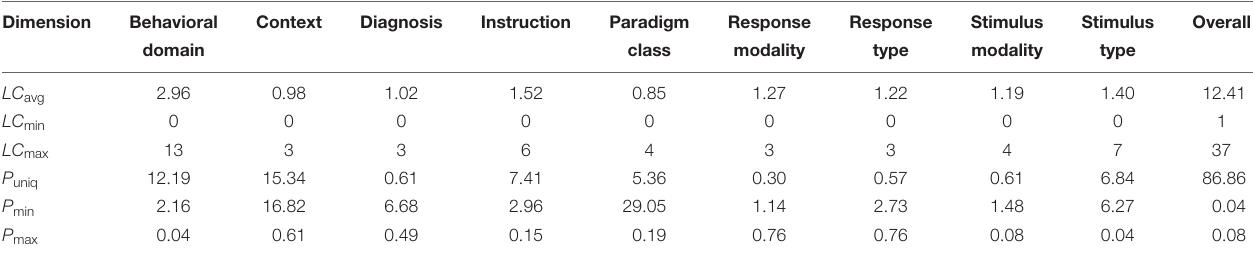
TABLE 1 | Label cardinality and set proportions.